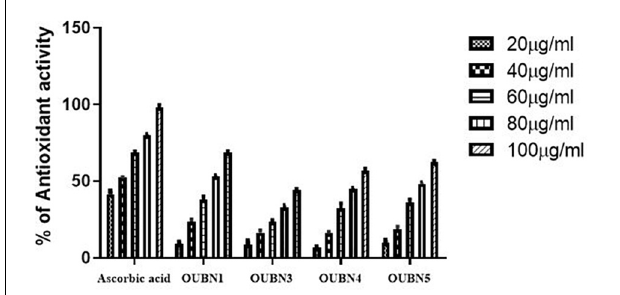
TABLE 5 | Antibiotic susceptibility of LAB strains isolated from toddy palm nectar samples. FIGURE 3 | Antioxidant abilities of LAB isolates by using CFS (cell free ZOI in mm supernatant) of 20, 40, 60, 80, 100 µ g/ml concentrations from Ascorbic acid, OUBN1, OUBN3, OUBN4, and OUBN5, respectively. Ascorbic acid was used as OUBN1 OUBN3 OUBN4 OUBN5